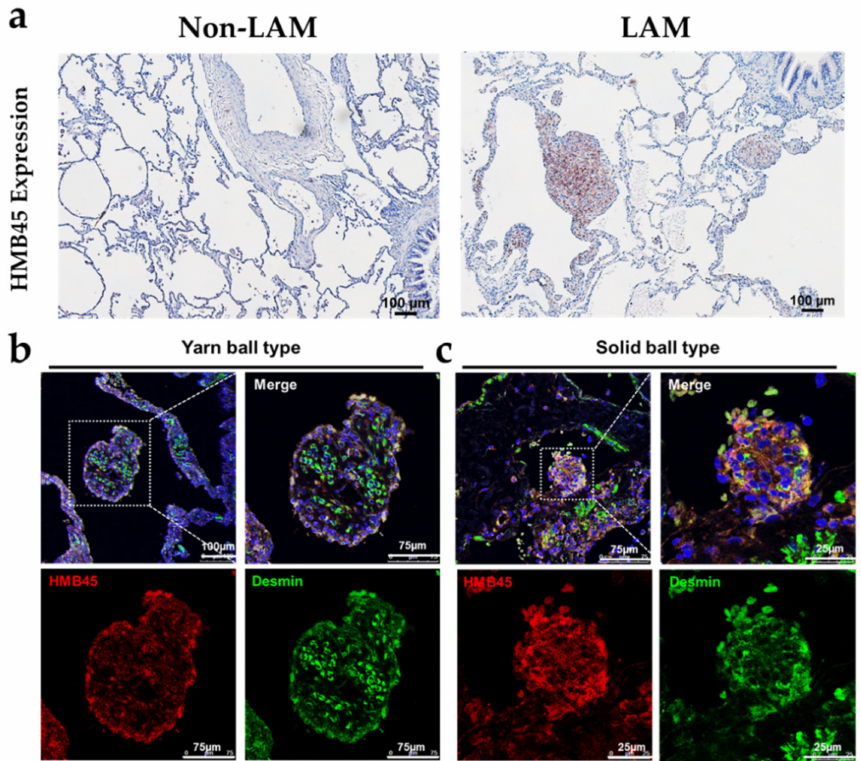
Figure 1. Histological appearance of lymphangioleiomyomatosis (LAM). ( a ) Immunohistochemistry shows HMB45 expression in cysts with cystic walls of variable thickness (scale bar: 100 µ m). The HMB45-positive LAM cells aggregated to form a solid mural nodule on the cyst wall, identified by brown staining. In contrast, anti-HMB45 signals were hardly detectable in the lungs of non-LAM patients. ( b ) Immunohistochemistry shows HMB45 expression in the external layer of the LAM nodule, with desmin double staining of SMC-like cells (scale bar: 75 µ m). Yarn ball: many SMC-like cells wrap around the LAM cell fascicles, producing anastomosing capillary-like channels reminiscent of a yarn ball. ( c ) Representative HMB45- and desmin-positive LAM cells aggregate to form a solid ball nodule (scale bar: 25 µ